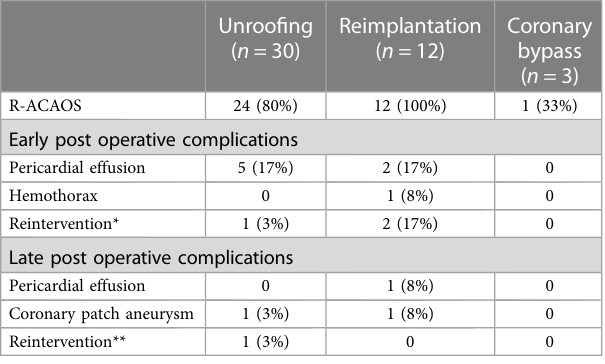
R-ACAOS: anomalous right coronary artery from the opposite sinus of Valsalva with an interarterial course. Data are shown as n (%). *Drainage of pericardial effusion n =2; drainage of hemothorax n =1. **Coronary patch aneurysm repair n